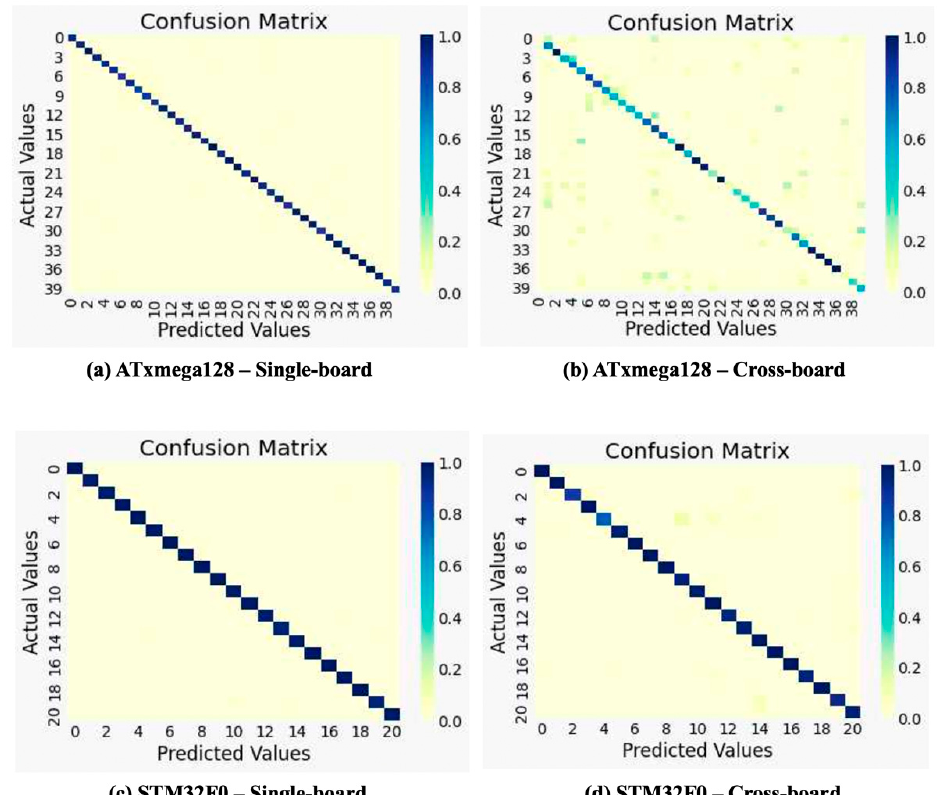
Figure 8. Confusion matrices of single-board and cross-board instruction recovery using MLP-10. Table 3. Instruction recovery accuracy using machine learning and deep learning models.